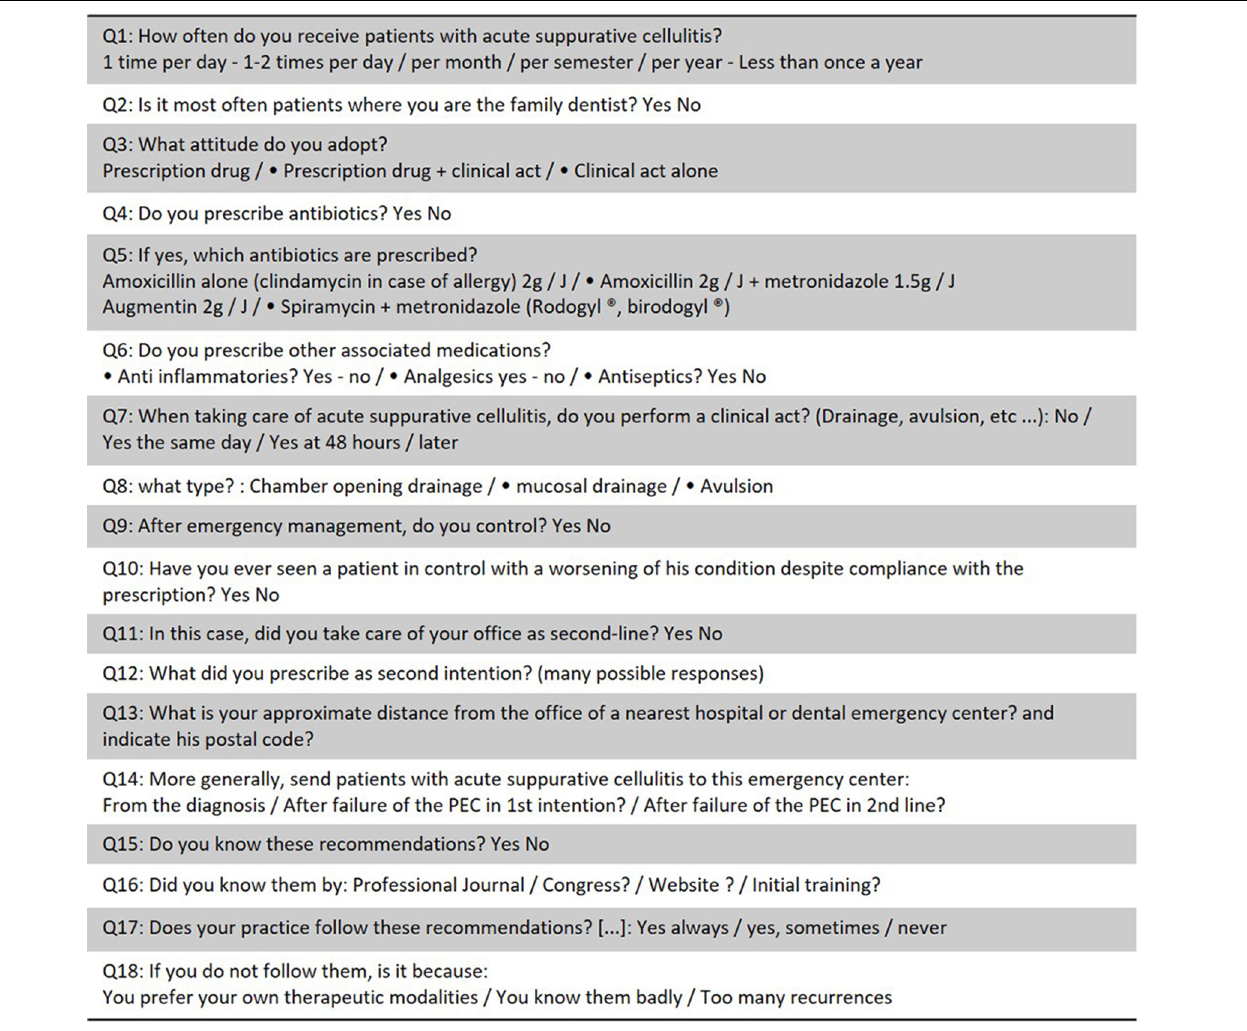
Table III. Summary of the main questions of the survey